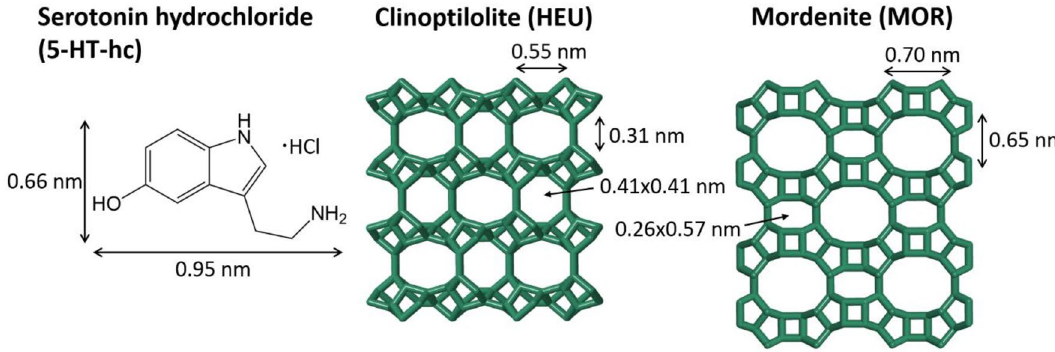
Figure 4. Structures of 5-HT-hc, clinoptilolite, and mordenite with the molecule and micropore dimensions. (5-HT-hc size from Chem3D by Perkin Elmer; zeolite pore dimensions from IZA homepage http:// www. iza- struc ture. org/ datab ases/ .